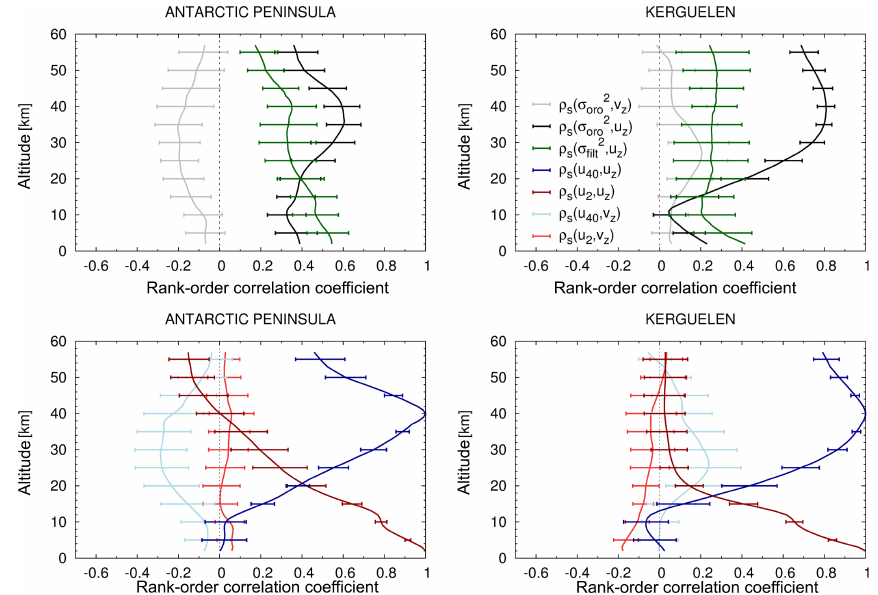
Figure 6. Top: interannual mean and standard deviation of rank-order correlation coefficients of AIRS 4.3µm brightness temperature vari- ance differences and ERA-Interim zonal winds (black) and meridional winds (gray) at different altitudes. Green curves show correlation coefficients restricted to cases with 40km zonal winds exceeding thresholds of 44ms − 1 at the Antarctic Peninsula and 72ms − 1 at Ker- guelen Islands, respectively. Bottom: rank-order correlations of 40km (blue) and 2km (red) zonal winds with zonal wind (dark colors) and meridional winds (light colors) at different